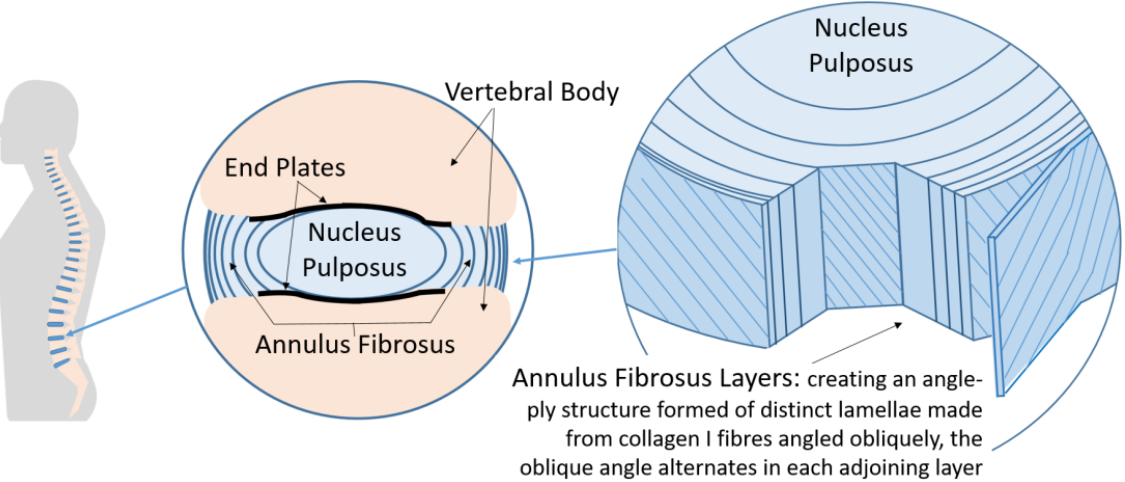
Figure 1. Intervertebral disc structure (IVD). ( Left ) The spine within the body containing the vertebrae (bone) separated by IVDs. ( Middle ) Sectional view of the IVD. ( Right ) Cutaway view of the IVD showing the angle-ply structure of the annulus fibrosus, adapted from [6].